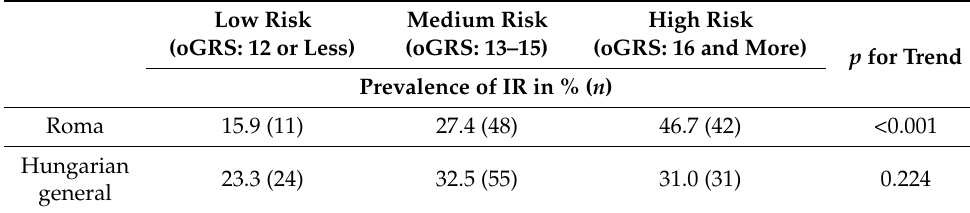
Table 3. The proportion of people with insulin-resistant (IR) conditions (HOMA—IR > 3.63) by genetic risk categories based on oGRS values in the Roma and Hungarian general